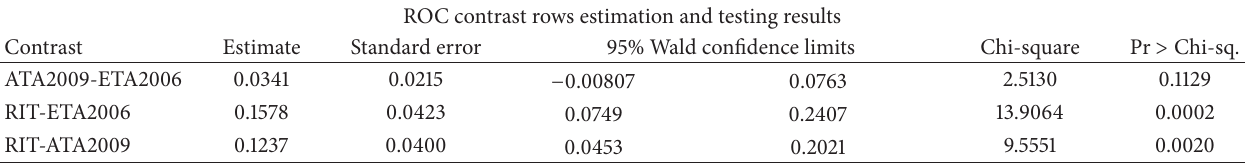
Table 5: Comparison of the area under ROC curves between the ETA, ATA, and RIT systems. ROC contrast rows estimation and testing